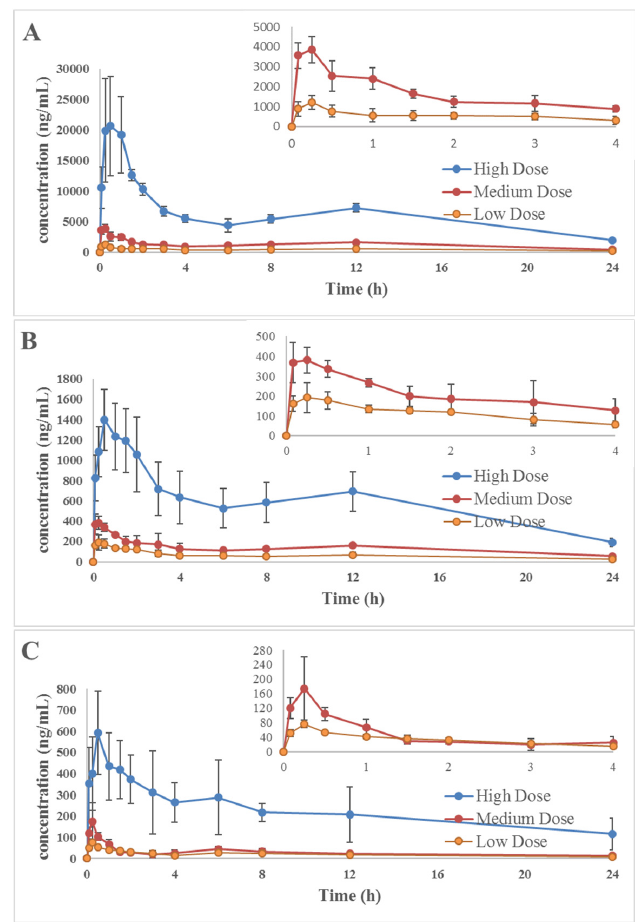
Figure 3. Mean concentration ‐ time profiles of carnosic acid ( A ); carnosol ( B ); rosmanol ( C ) in rat plasma after oral administration of rosemary. Each point represents the mean ± SD ( n = 6).